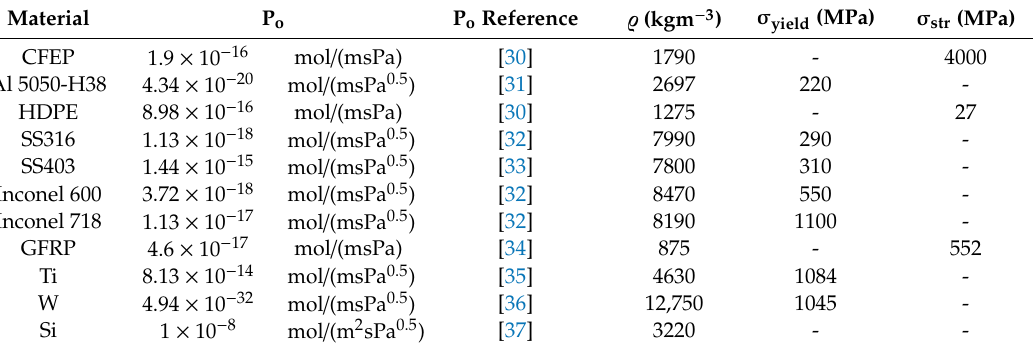
Table 4. Properties of the studied